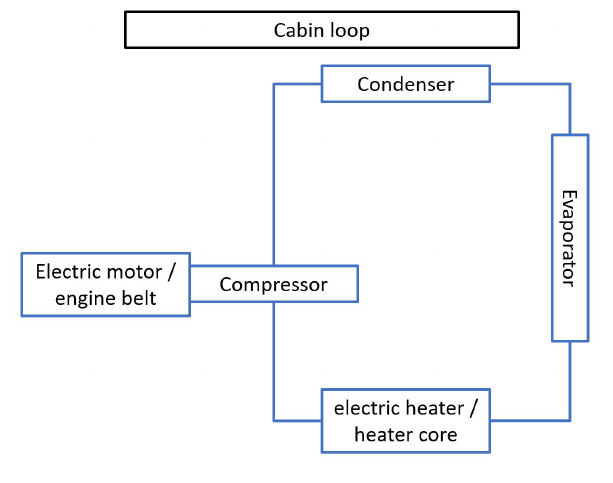
Figure 4. Scheme of a cabin conditioning